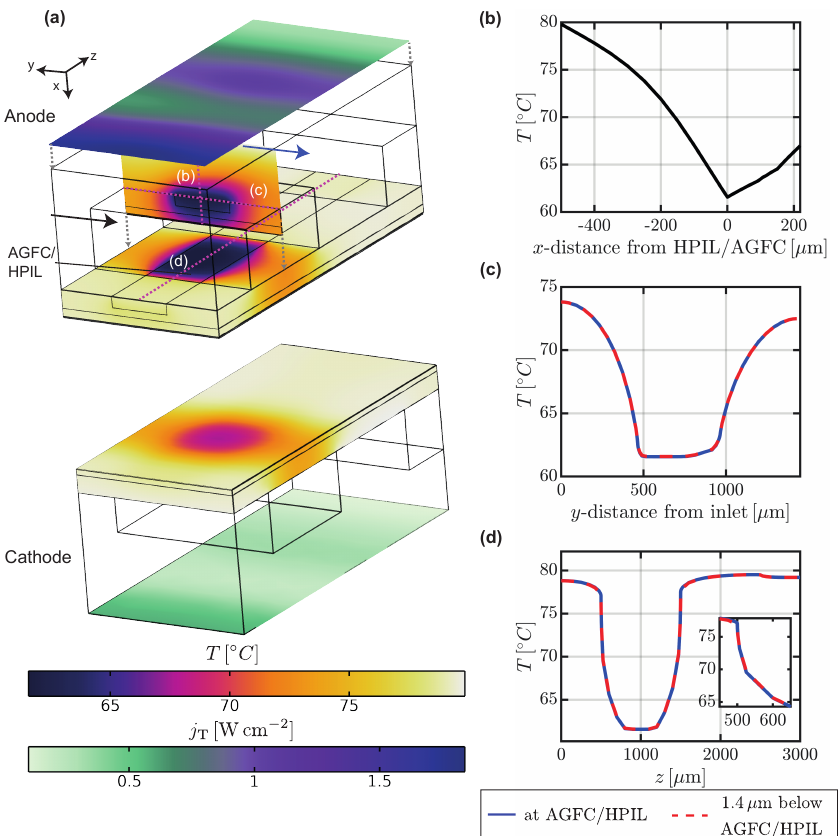
Figure 7. Base case model results: ( a ) 3-D plot of temperature and heat flux and ( b – d ) profiles of temperature. Magenta dashed lines in ( a ) indicate each profile’s